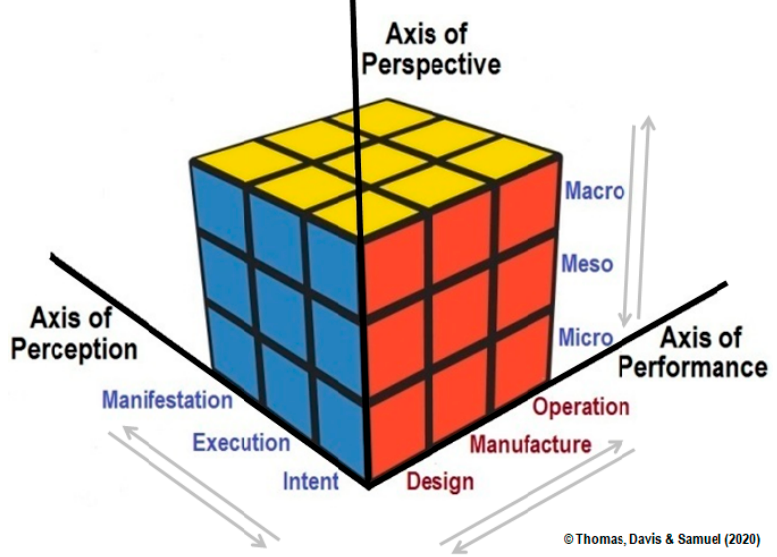
Figure 2. The Rubik’s Cube Model of Integration-in-Totality Principle.